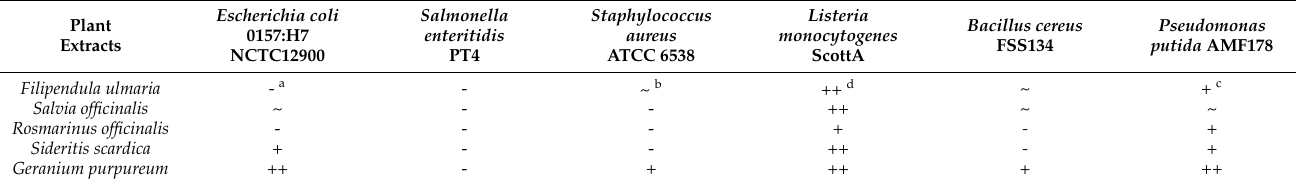
Table 5. Plant extract’s antimicrobial activity (sample amount 5 µ L; n = 3). Plant